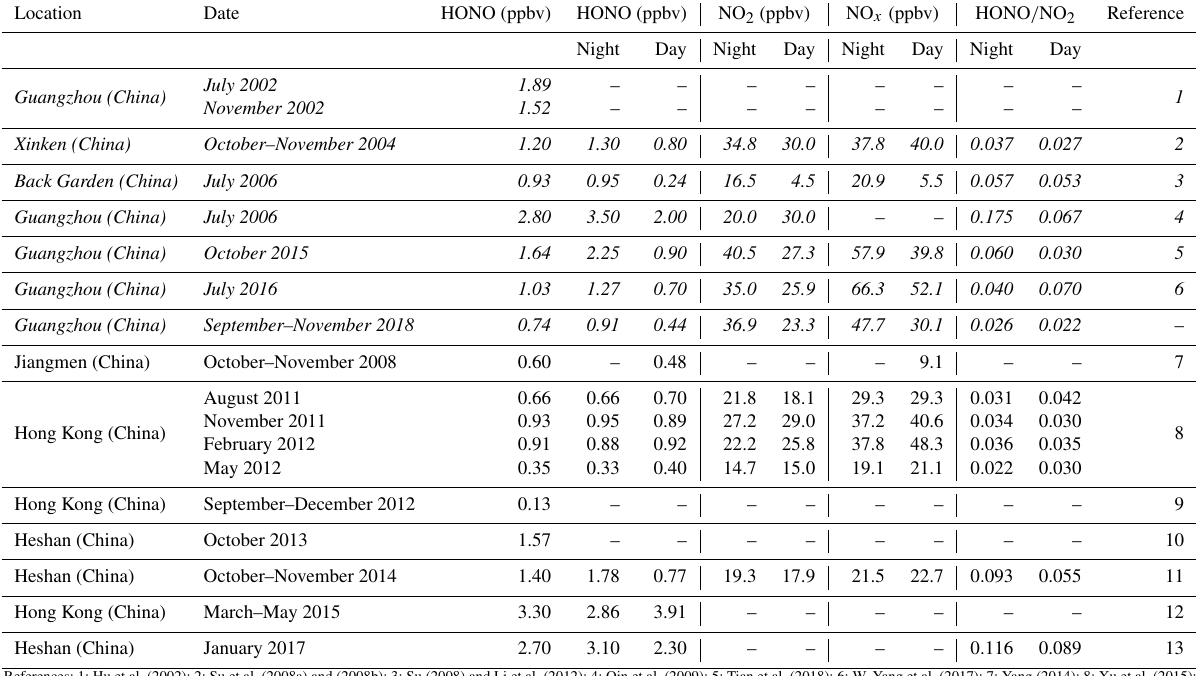
Table 1. Overview of the ambient HONO, NO 2 , and NO x measurements as well as the HONO / NO 2 ratios in the PRD region ordered chronologically. Data from Guangzhou are in